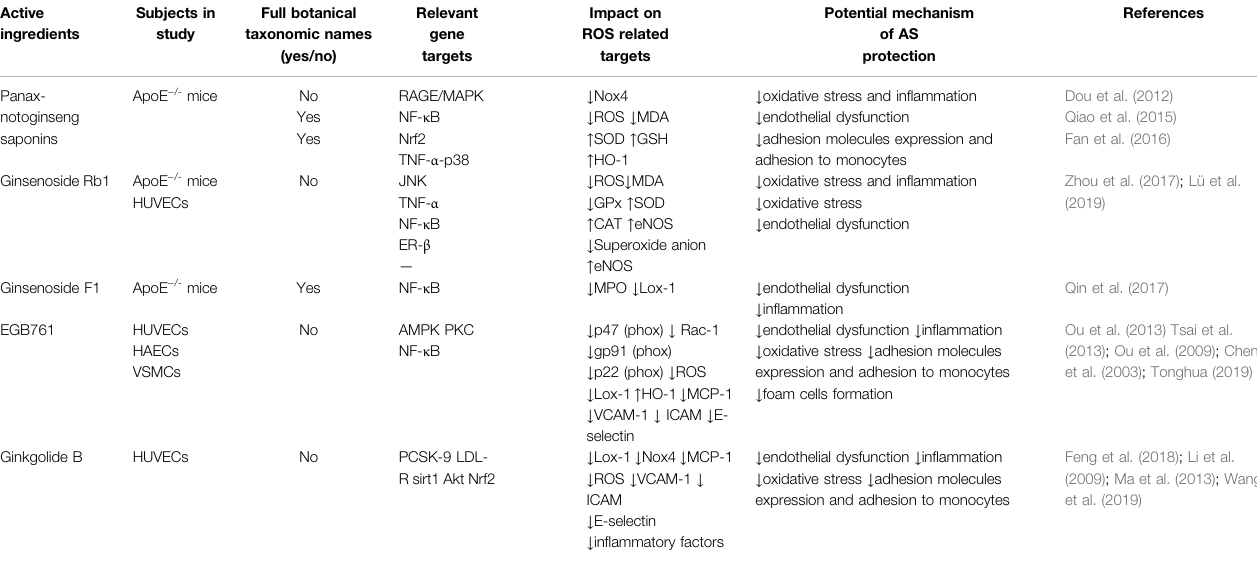
TABLE 7 | Other active ingredients in herbs that treat atherosclerosis by regulating oxidative stress. Active Subjects in ingredients